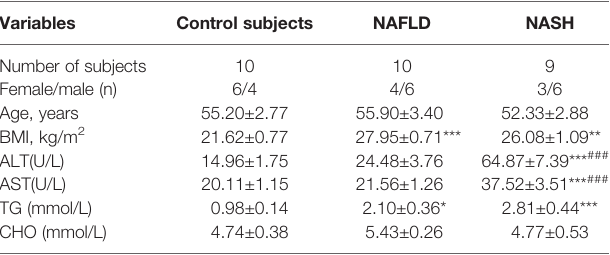
TABLE 1 | Clinical and biochemical features of patients with NAFLD, NASH patients and the control